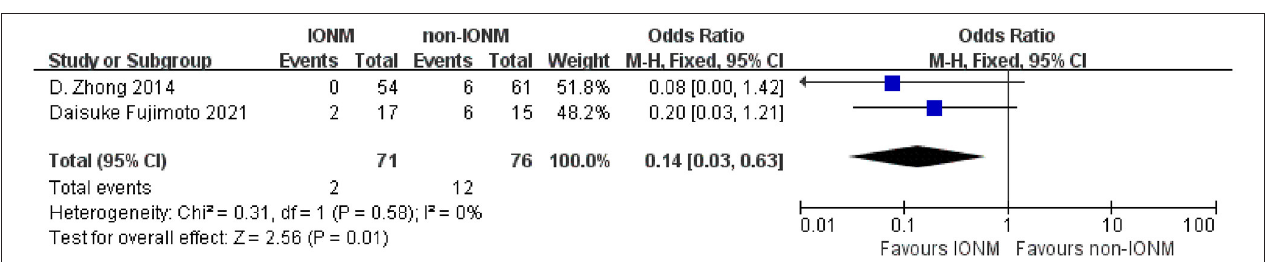
FIGURE 9 | Forest plot of hoarseness in the IONM and non-IONM